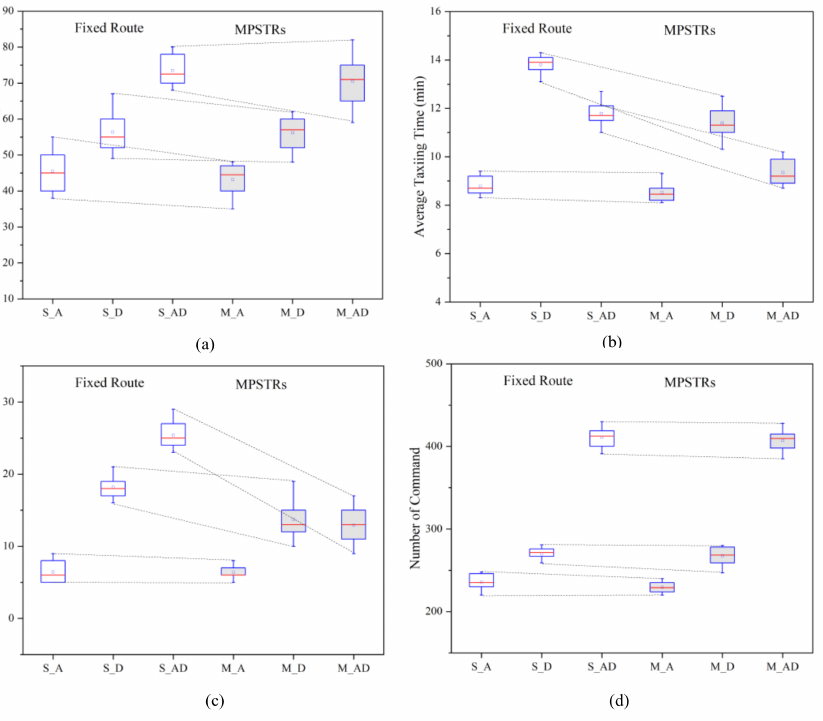
Figure 13. Box plots of dependent measures, for all six scenarios. ( a ) The workload rating; ( b ) average taxiing time; ( c ) number of potential conflicts; ( d ) number of